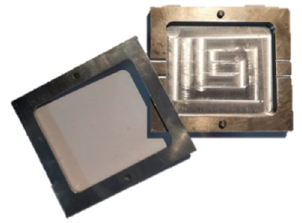
Figure 1. Mould used to form the composite.